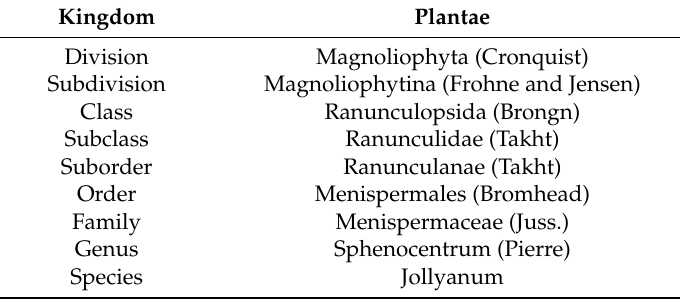
Table 1. Taxonomical classification of Sphenocentrum jollyanum